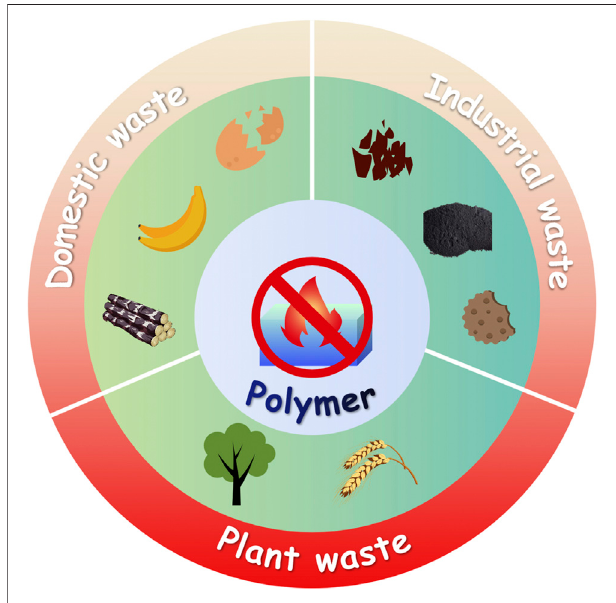
Frontiers in Materials |